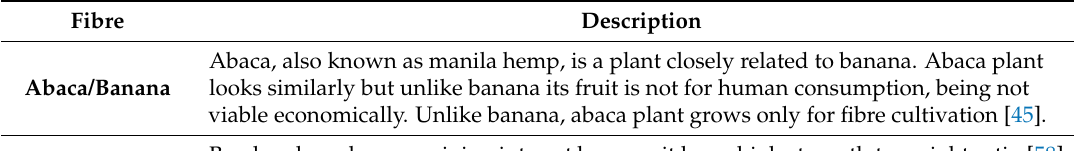
Table 3. Summary of Natural Fibres characteristics. Adapted from [45,58 – 69].